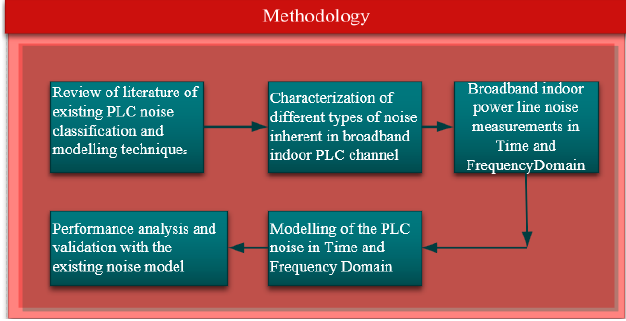
Figure 2. Methodological